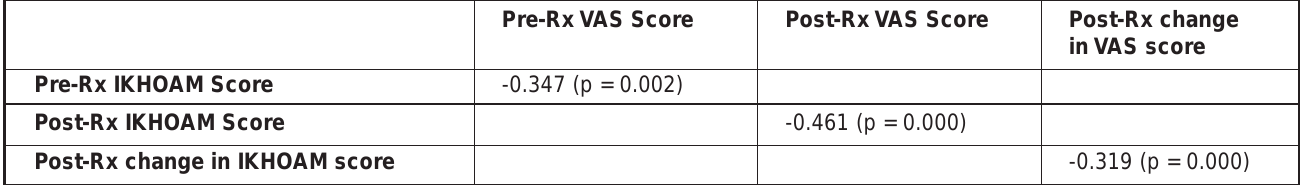
Table 2: Spearman’s Correlation Coefficient between IKHOAM and VAS Scores of